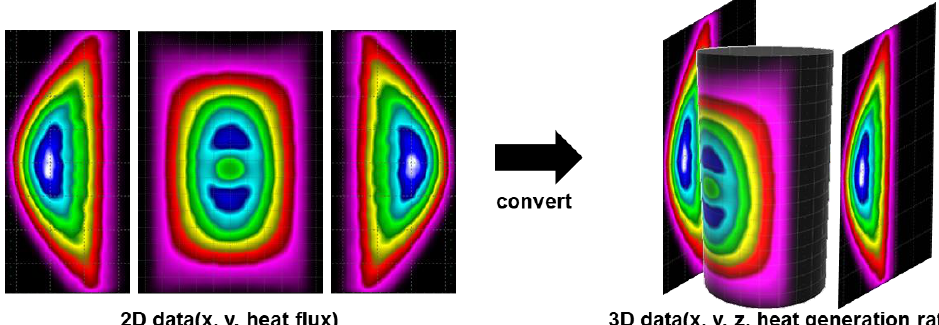
Figure 15. Transformation of 2D optical results to 3D CFD boundary condition.